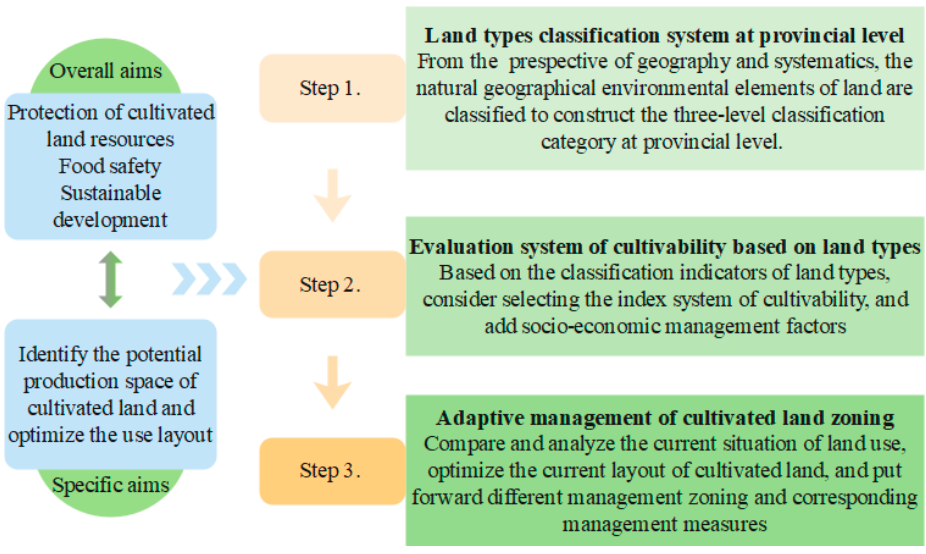
Figure 1. The research steps framework.